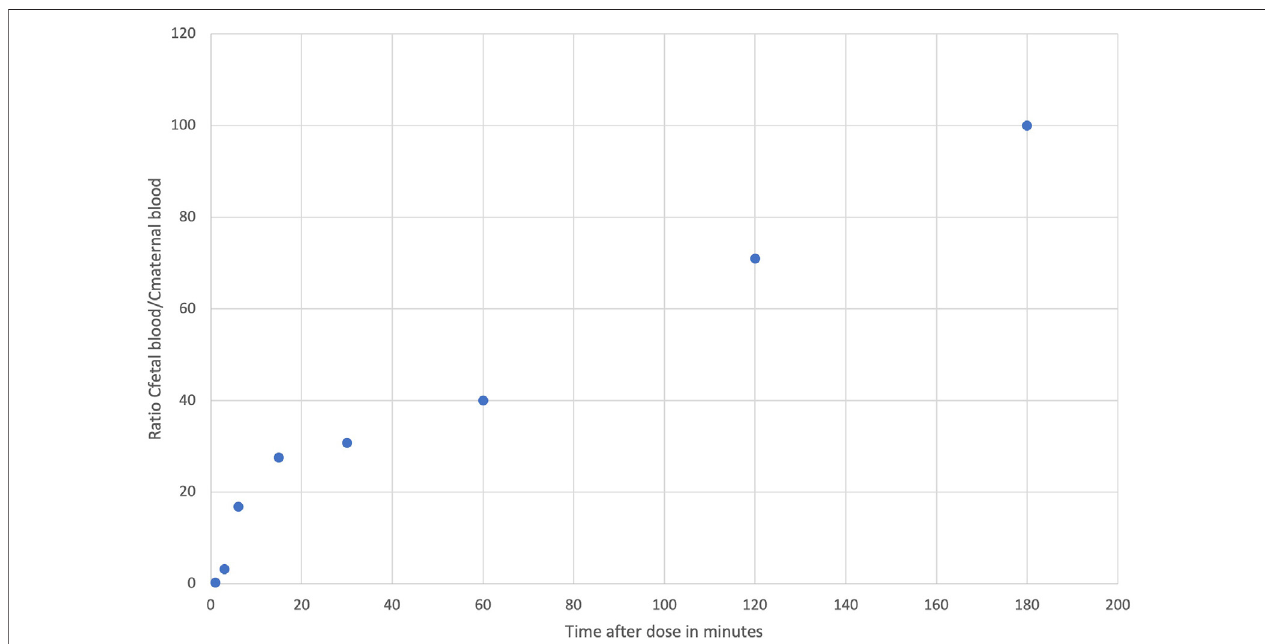
FIGURE 2 | Ratios of fetal concentrations over maternal concentrations over 3 h in rhesus monkeys based on data obtained by Bailey et al. (1987).